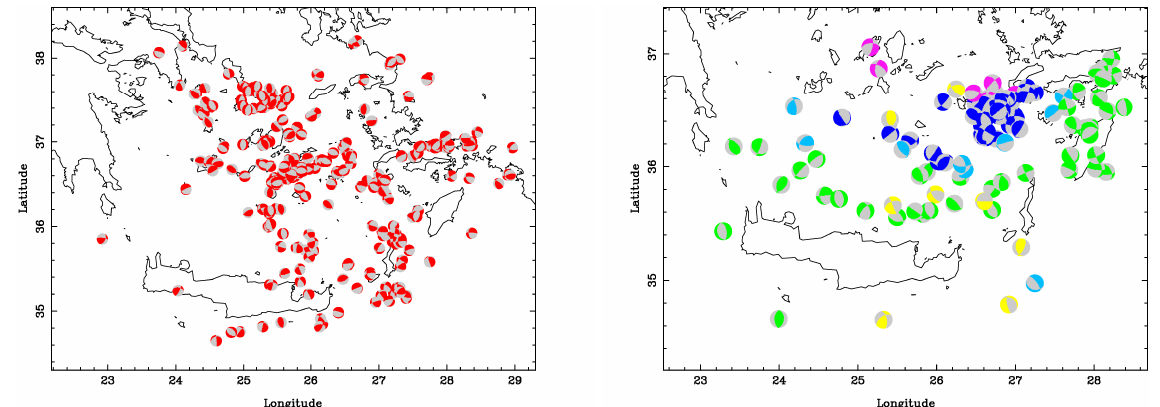
Fig. 3. Map of earthquakes for which focal mechanisms could be determined from first motions. Left: Shallow earthquakes. Right: Earth- quakes deeper than 20 km. Colour of beach balls indicates source depth. Red: 0-20 km, yellow: 20-40 km, green: 40-80 km, blue: 80-100 km, deep blue: 100-150 km, magenta: > 150 km